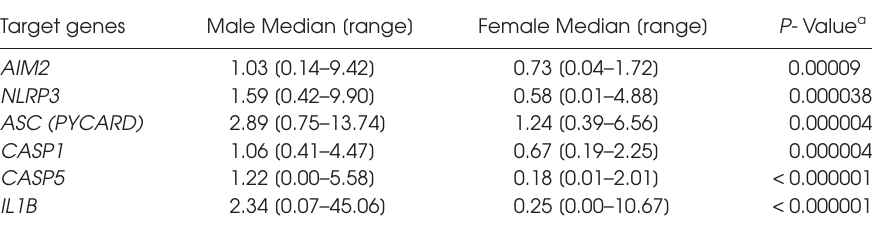
Table 2. Relative mRNA levels of inflammasome components in PBMC normalized to ACTB/GAPDH/B2M . Data are derived from 62 male and 38 female patients.